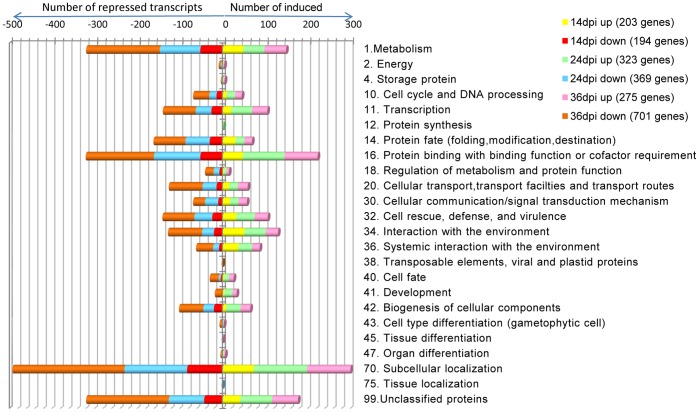
MIPS functional distribution categories of 2-fold differentially expressed transcripts in SACMV - infected Arabidopsis
 leaf tissues at 14, 24 and 36 dpi.